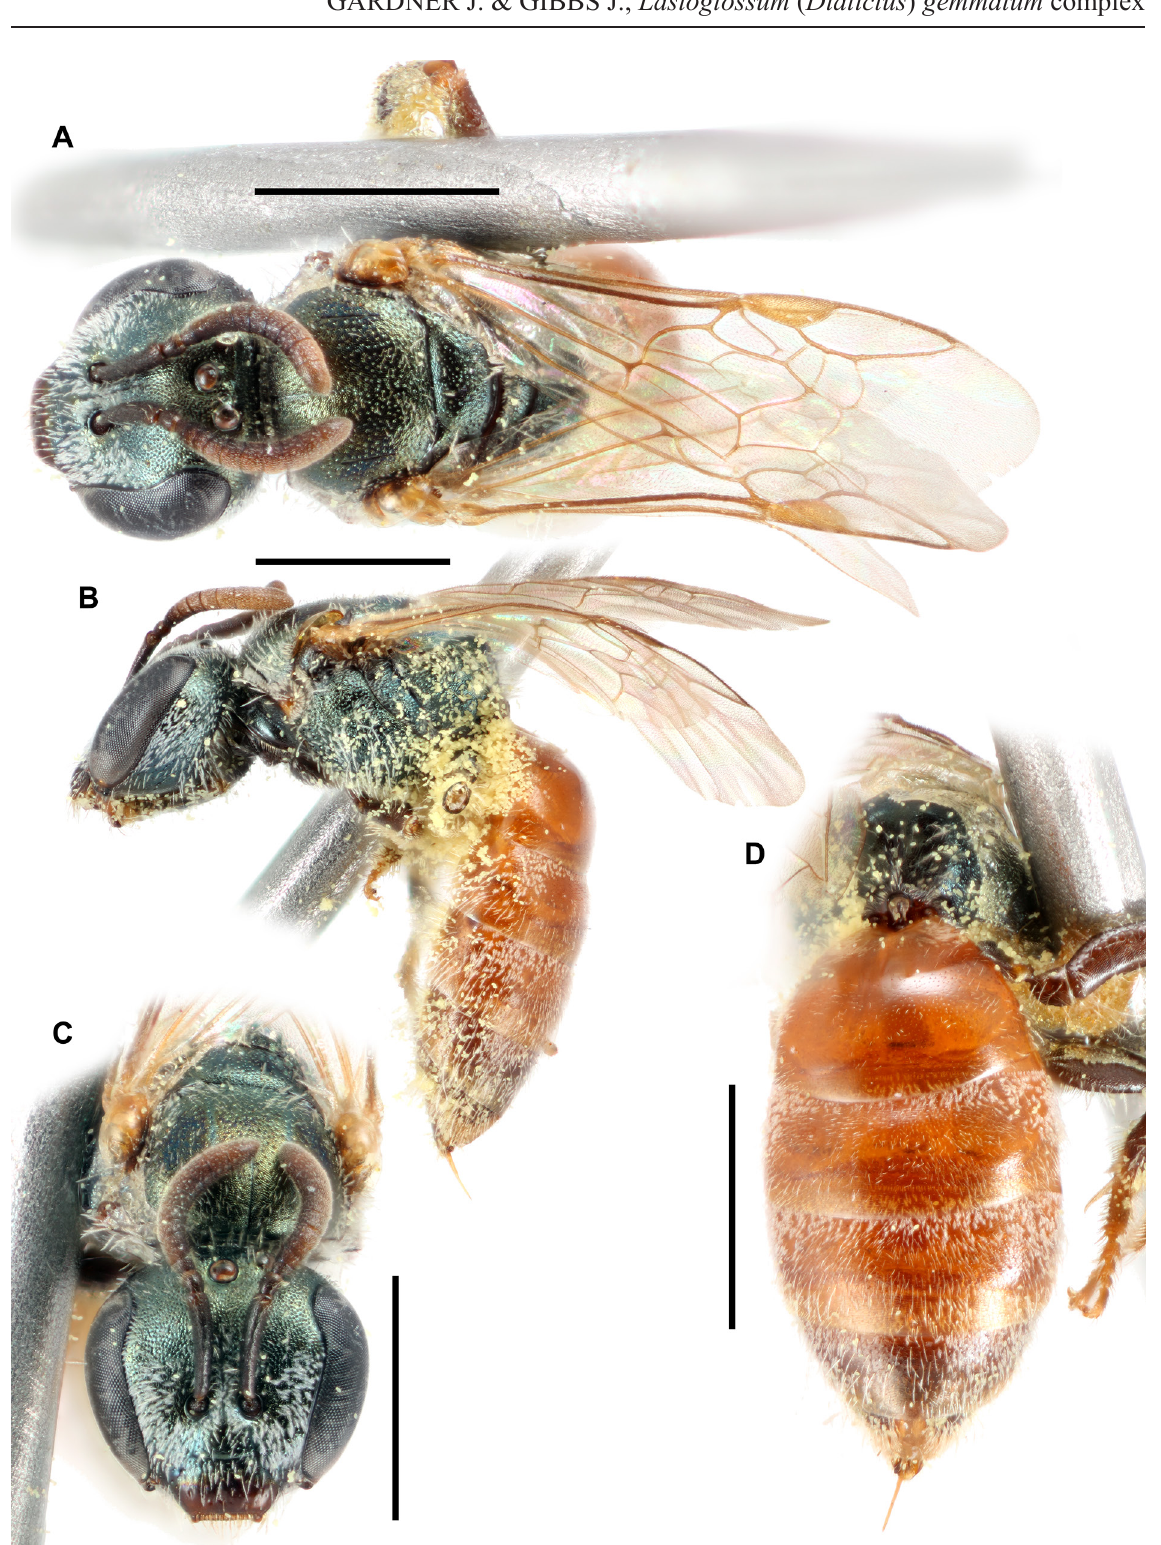
Fig. 57. Lasioglossum ( D .) rufodeludens sp. nov., ♀, holotype (PCYU). A . Dorsal habitus. B . Lateral habitus. C . Face. D . Metasoma. Scale bars = 1